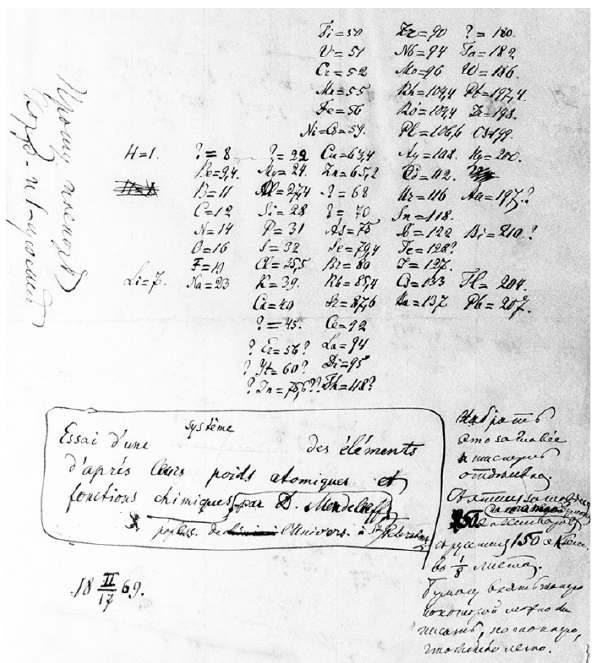
Figure. 1. The hand-written copy of the “Attempt” that would be published under the title “Attempt at a system of elements based on their atomic weights and chemical similarity” in both Russian and French, and kept at the Mendeleev Museum and Archives, Saint Petersburg State University, Saint Petersburg,